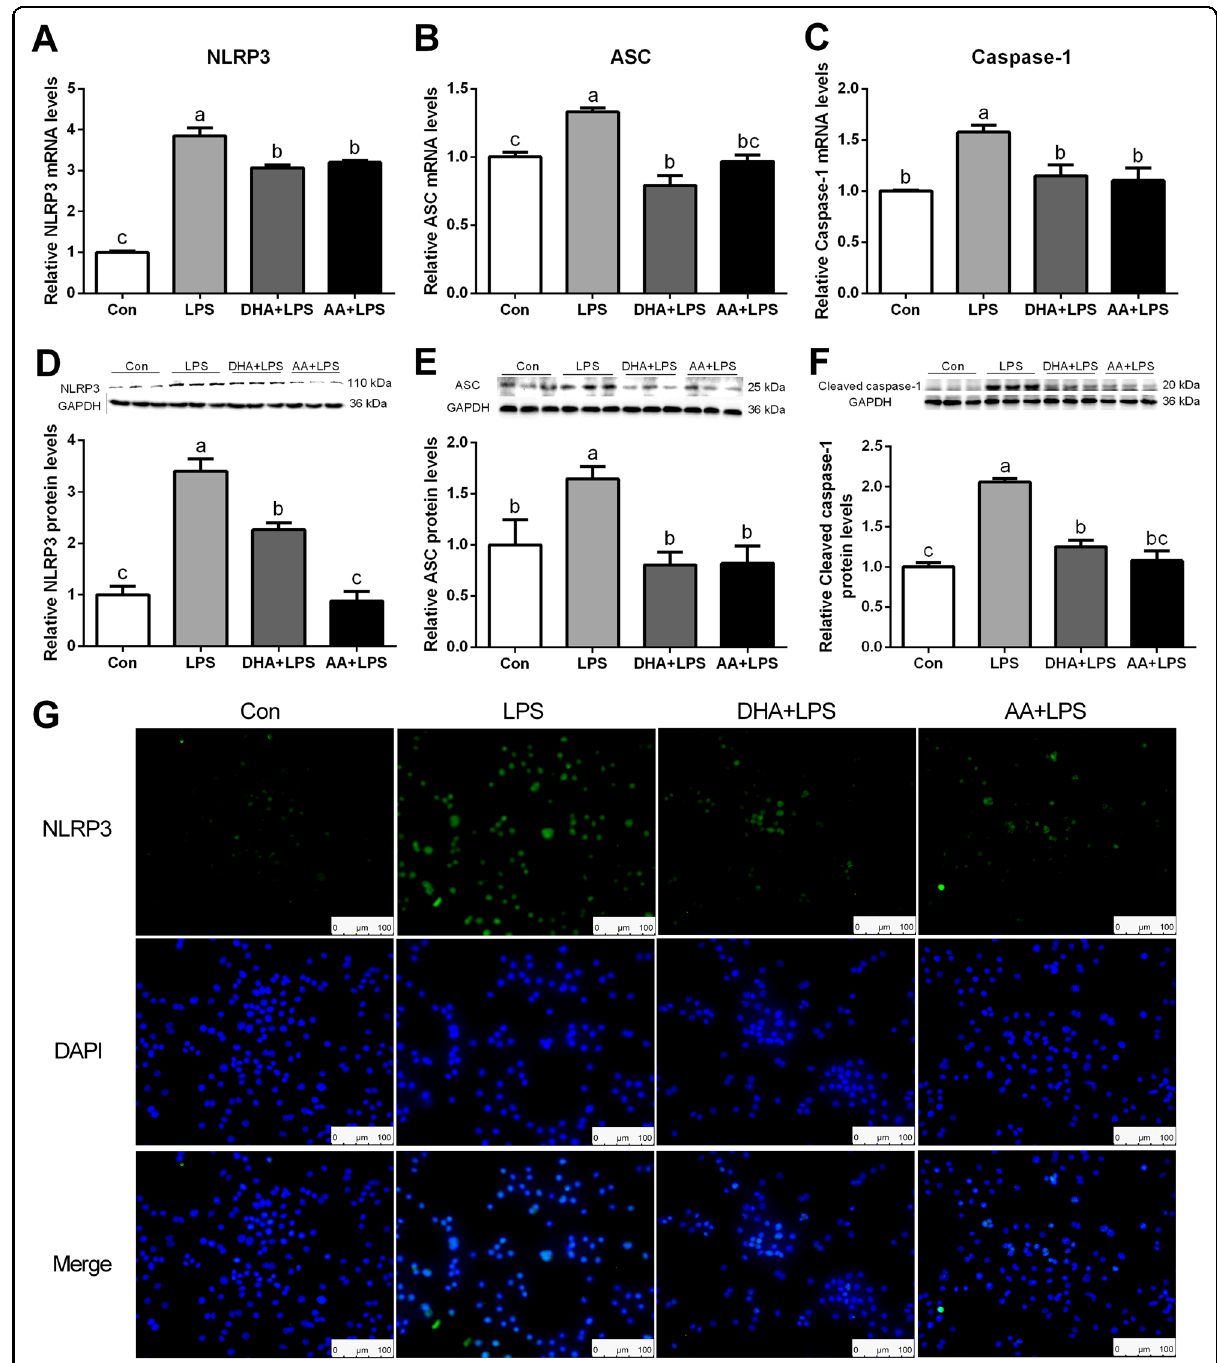
Fig. 1 DHA/AA inhibited NLRP3 in fl ammasome-mediated pyroptosis in LPS-induced Kupffer cells. A – C Kupffer cells were pretreated with 50 μ M DHA/AA for 4 h and then treated with 100 ng/mL LPS for 6 h. The mRNA levels of NLRP3, ASC, and caspase-1 were determined by quantitative real-time PCR. D – F Kupffer cells were pretreated with 50 μ M DHA/AA for 4 h and then were treated with 100 ng/mL LPS for 12 h. The protein levels of NLRP3, ASC, and caspase-1 were determined by western blot analysis. G NLRP3 expression was measured by immuno fl uorescence. In the bar graph, data represent the means ± SEM, n = 3 per group. Mean values not sharing the same letters are signi fi cantly different, P <